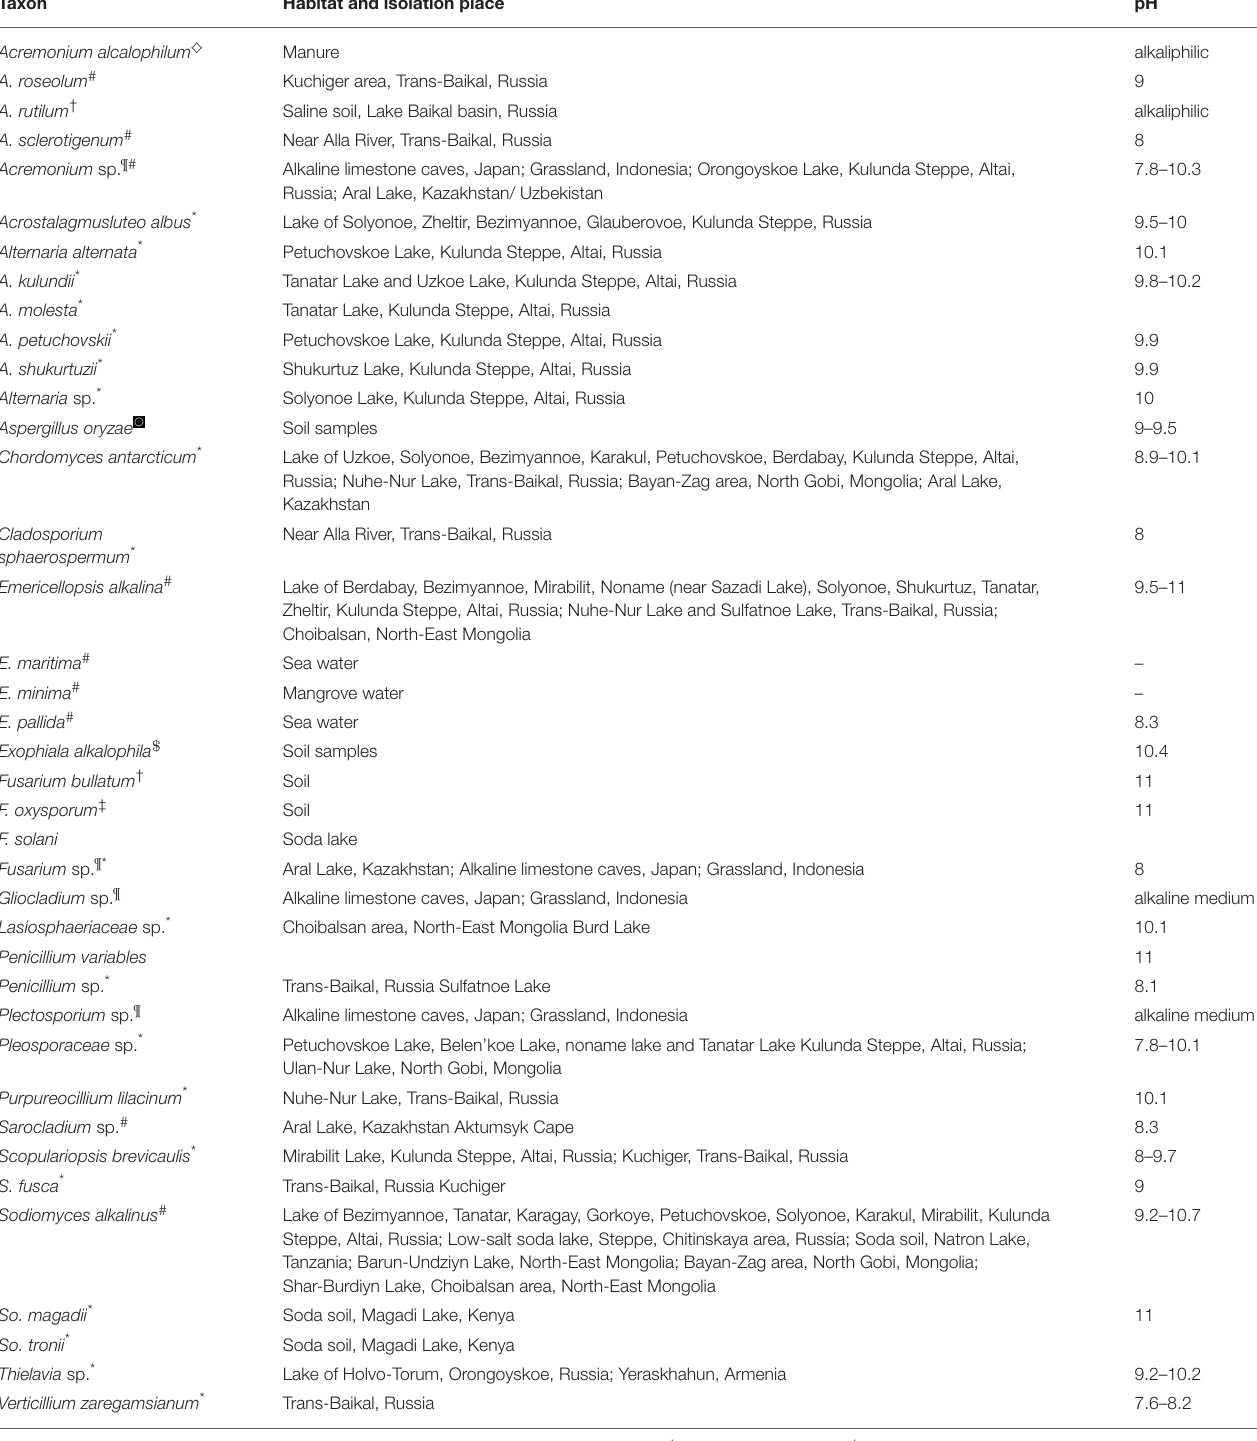
TABLE 6 | Fungal species isolated from various hyper alkaline and hyper saline environments around world with the data on the habitats they were isolated